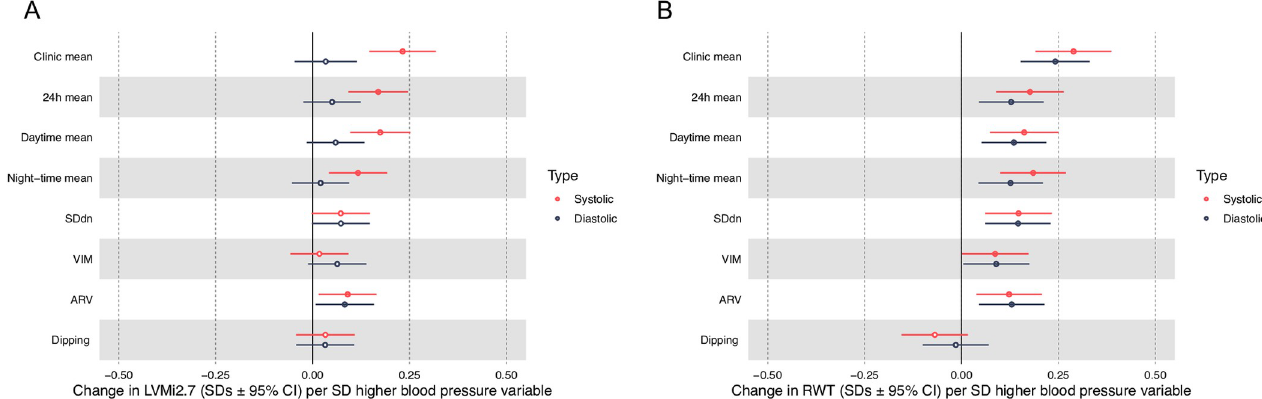
Fig 2. Forest plot of the mean difference in echocardiographic structures (SDs) per SD higher blood pressure (BP) variable in the confounder model. A) Left ventricular mass indexed to height 2.7 (LVMi 2.7 ) B) Relative wall thickness (RWT). SDdn = Standard deviation weighted for day and night, VIM = variability independent of the mean, ARV = average real variability. Filled estimates where p <